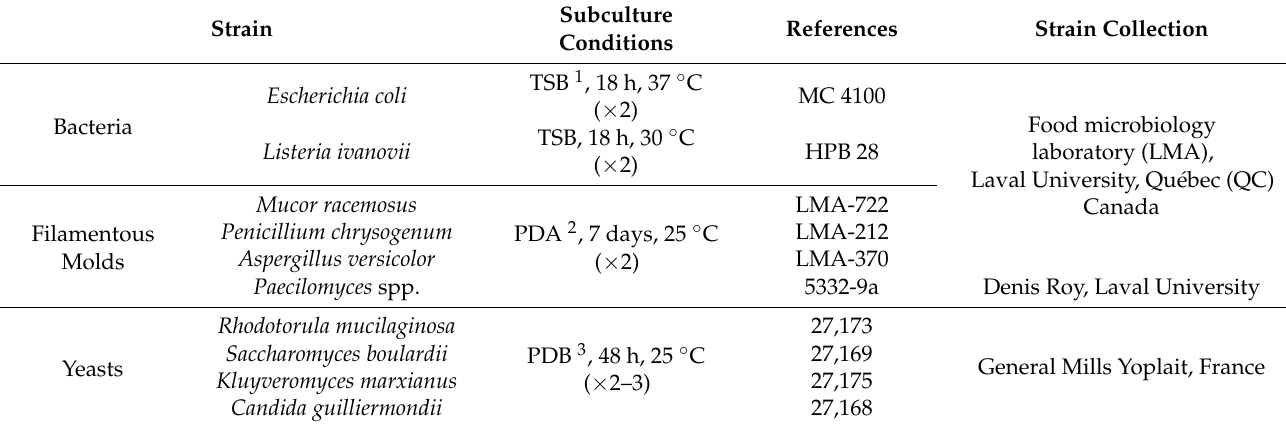
Table 1. Strains used for antimicrobial assays on hydrolysates and